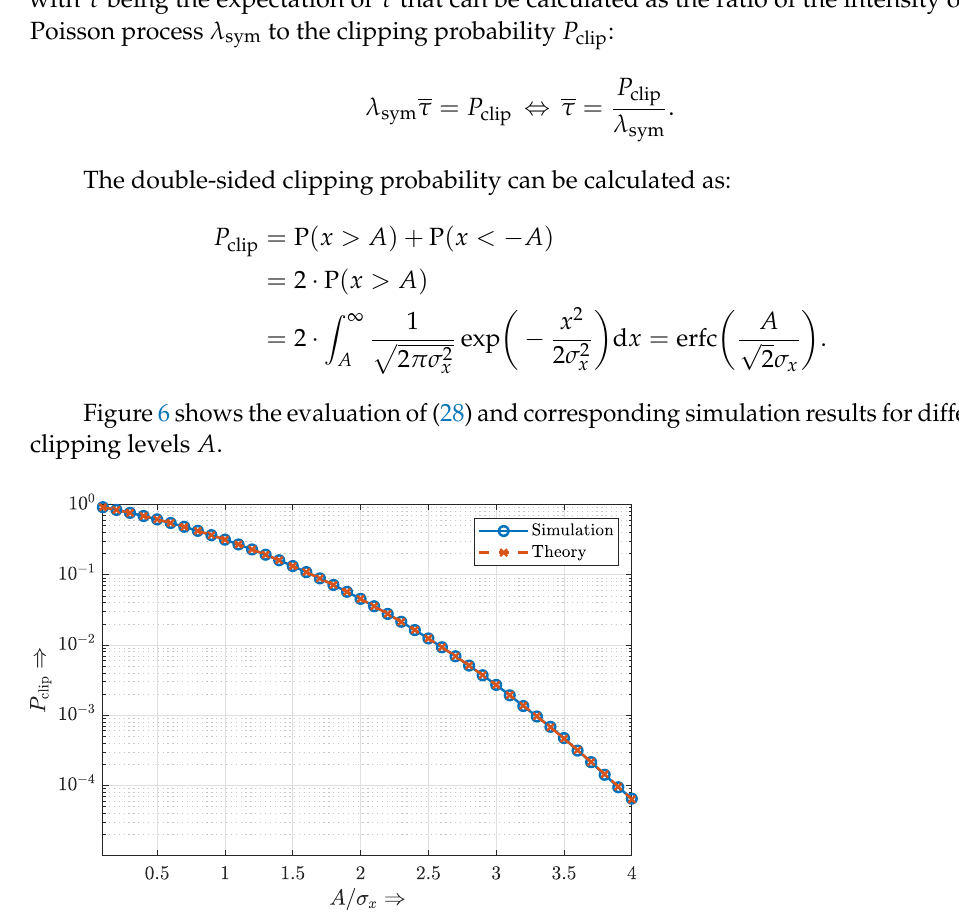
Figure 6. Linear damping factor K for different clipping levels A